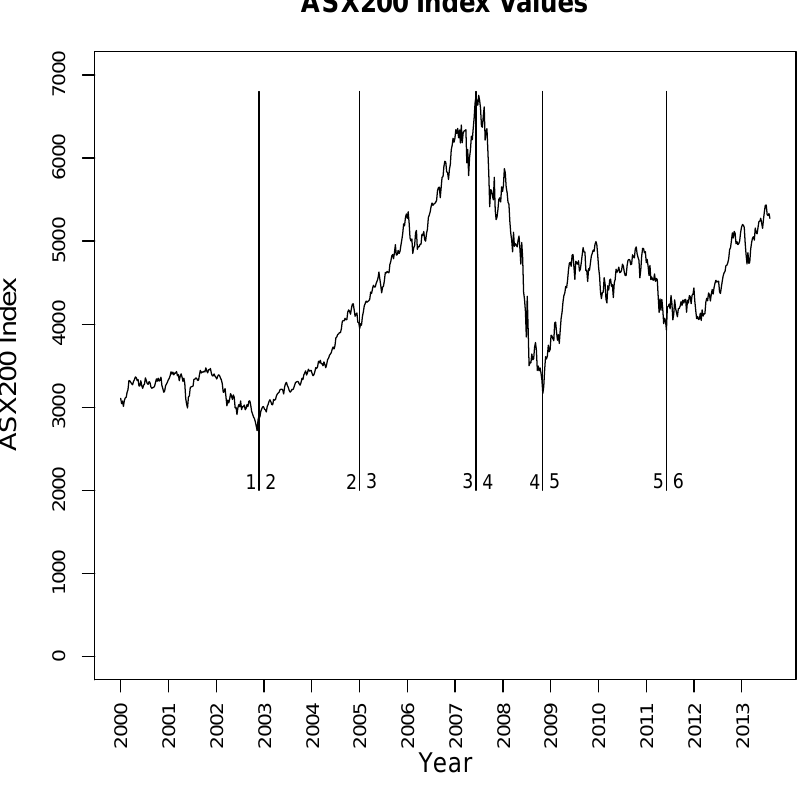
Figure 1. A plot of the ASX200 Index with the boundaries of the study periods